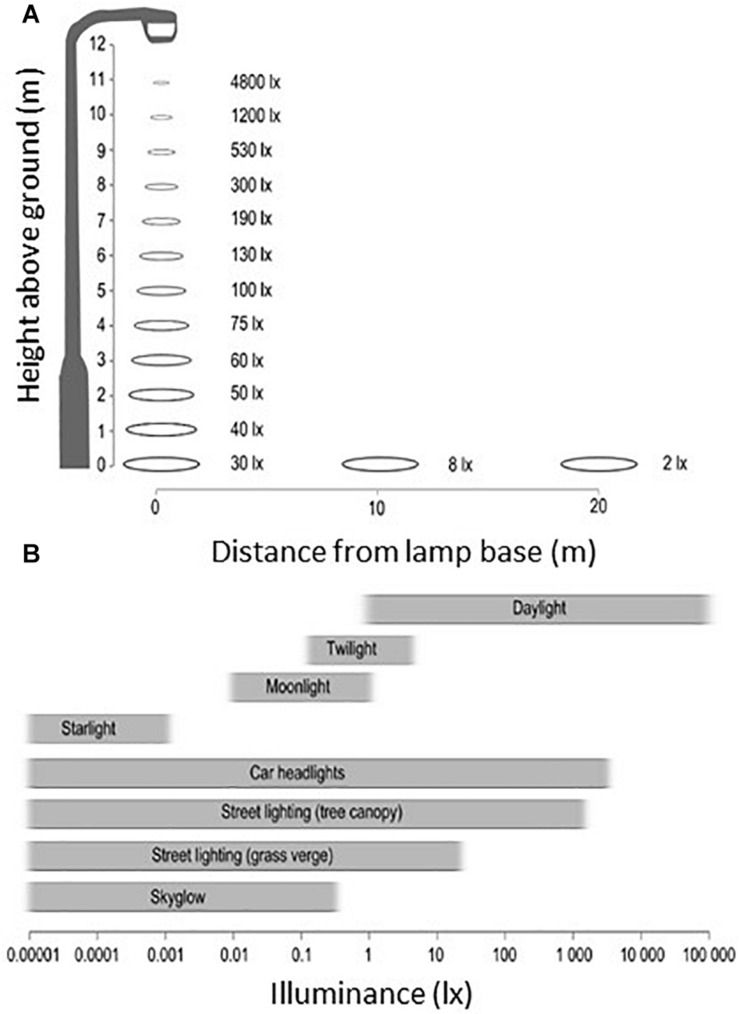
(A) Illuminance measured in the horizontal plane from a typical street light (Phillips Cosmopolis, metal halide lamp). The illuminance level decays rapidly with distance to the lamp. (B) Comparison of measured illuminance from natural sources of light to artificial light sources – axis is on a logarithmic scale, and bars present approximate ranges based on field measurements. From Bennie et al. (2016). No special permission required.